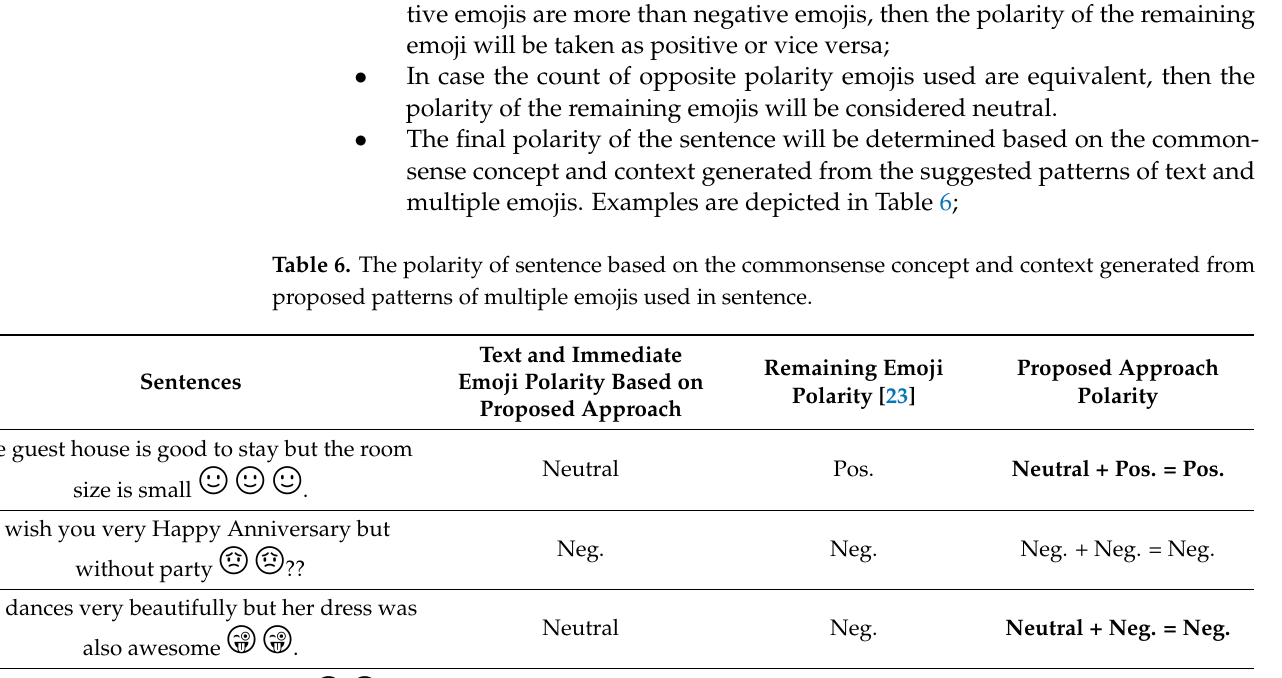
Table 7. Proposed work results for various ensemble of the linguistic features available in senti- ment sentences.